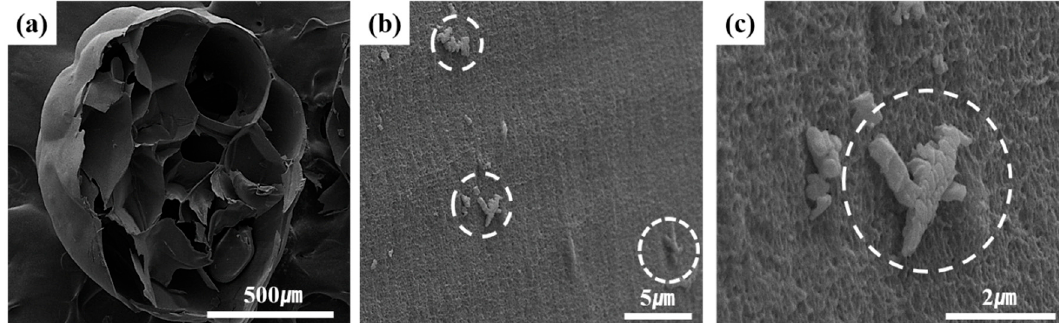
Figure 3. Scanning electron microscopy images of the inside of dried alginate bead encapsulating FKC. The dashed circles indicated the location of the FKCs on the alginate network. ( a ) half-crushed dried alginate bead; ( b ) assemblies of FKC; ( c ) magnified images of FKC.